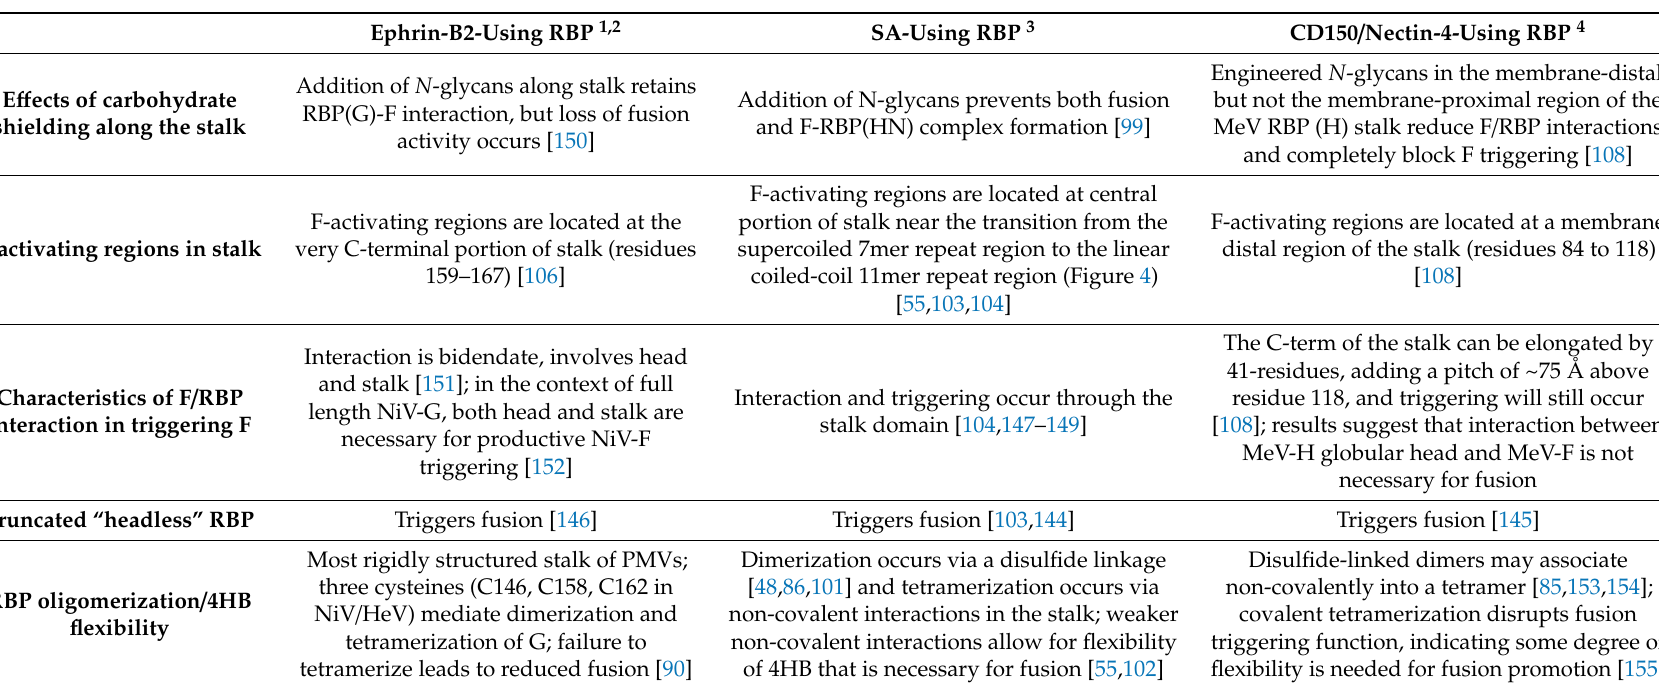
Table 1. Comparison of fusion promotion mechanisms for PMV Receptor Binding